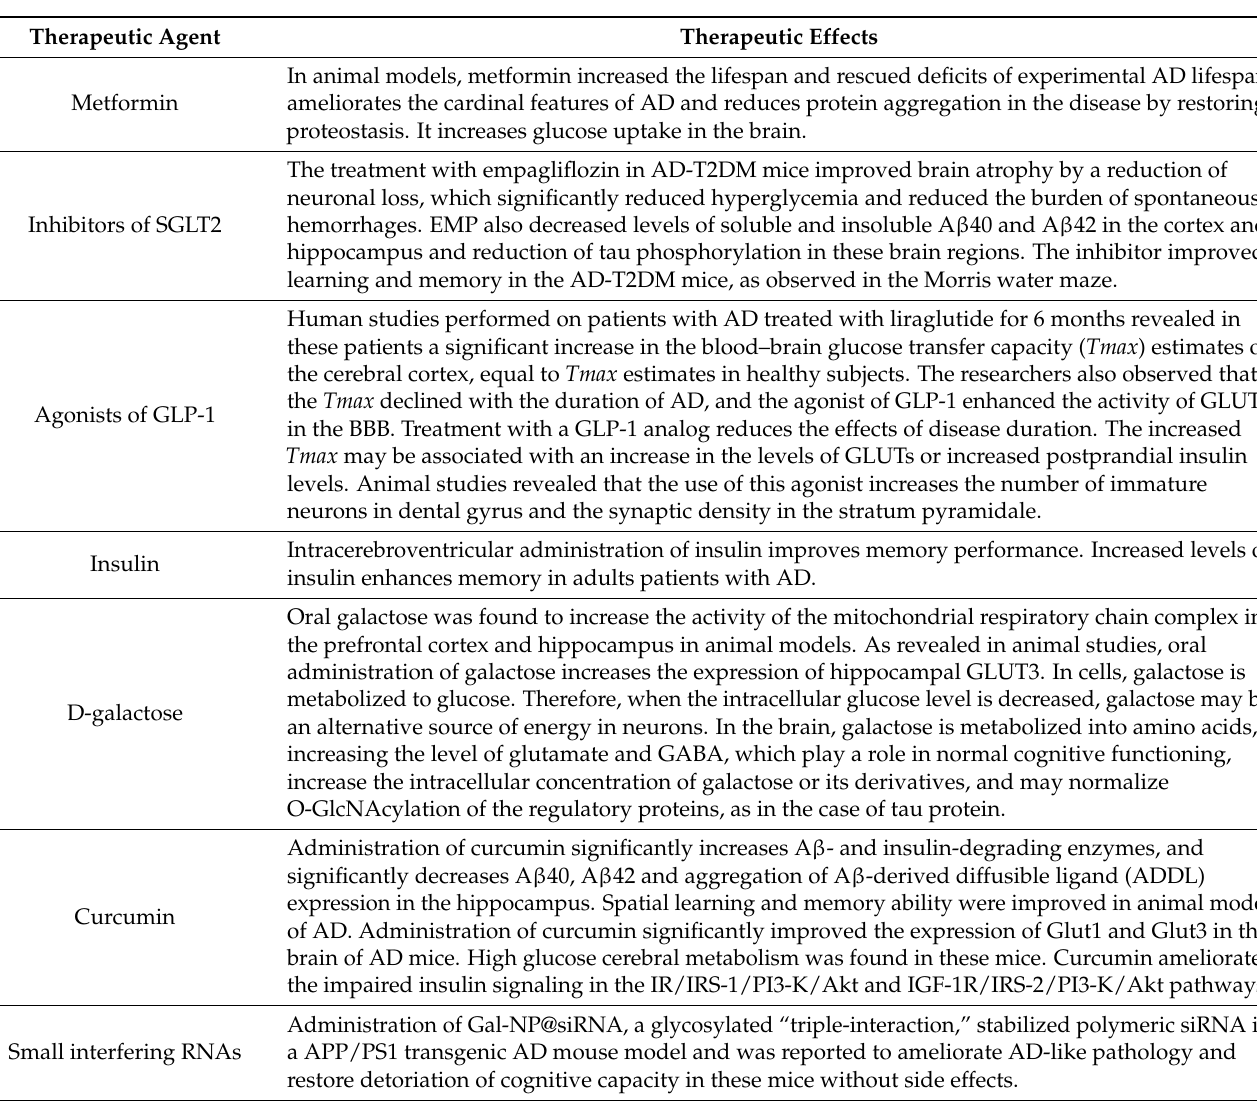
Table 1. The effects of different therapies in Alzheimer’s